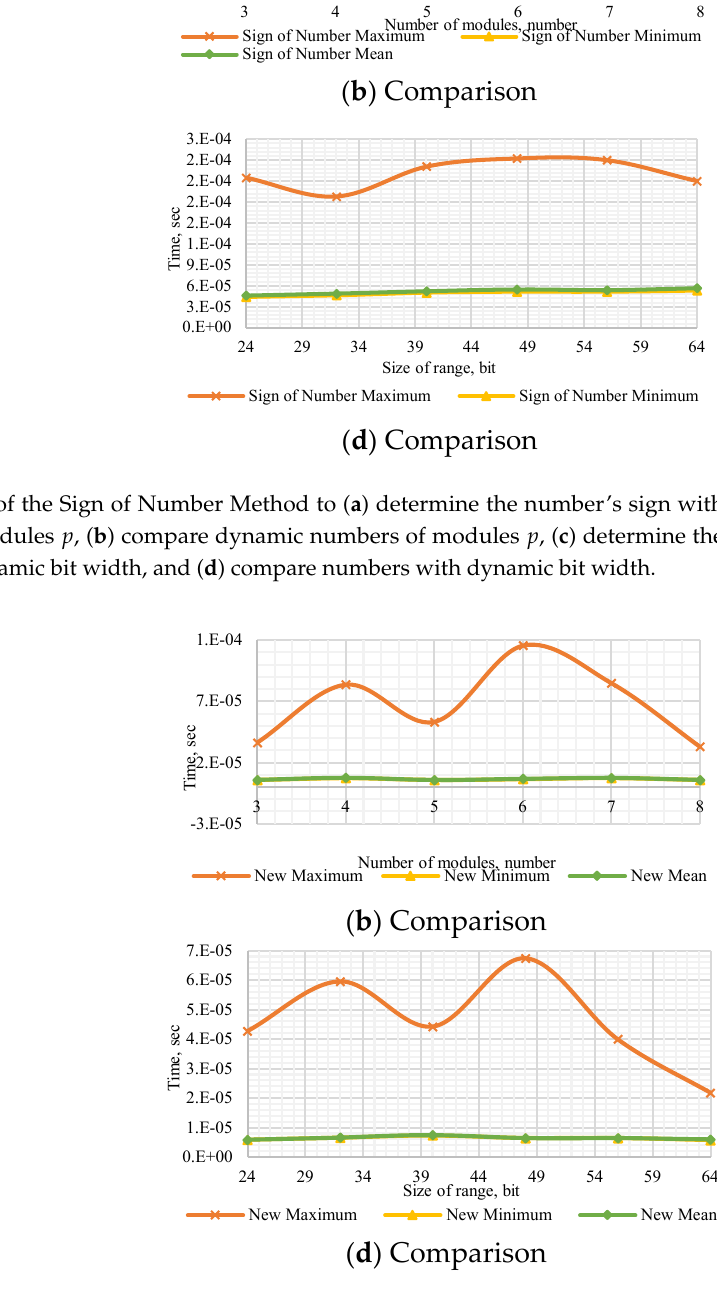
Figure A8. Performance of the DSN-EN method to ( a ) determine the number’s sign with a dynamic number of modules p , ( b ) compare dynamic numbers of modules p , ( c ) determine the number’s sign with a dynamic bit width, and ( d ) compare numbers with dynamic bit width.